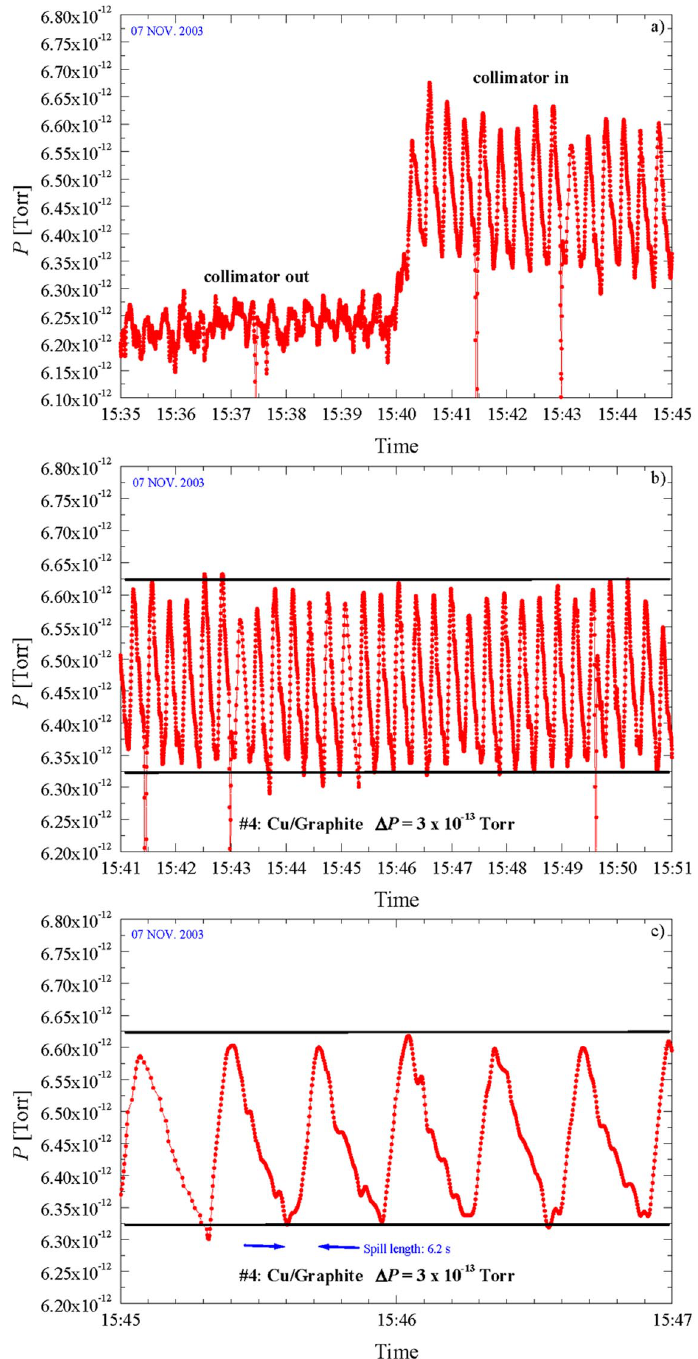
FIG. 4. (Color) Pressure rises of the Cu = graphite collimator bombarded under 35 mrad with 158 GeV = u In 49 (cid:1) ions at the SPS. The intensity was (cid:7) 1 : 5 (cid:2) 10 6 ions = spill with a spill length of 6.2 s. (a) Pressure rise when the sample was moved at 15:40 h into the ion beam, (b) pressure rise during continuous bombardment, and (c) magnification of to the temperature rise # T is then given by tions and the subsequent temperature calculations carbon was taken into account with a density of 1 : 84 g = cm 3 and a E dep : specific heat capacity of 795 J = (cid:9) kg K (cid:10) . Copper was simu- # T (cid:4) (cid:18) (cid:2) c lated with a density of 8 : 96 g = cm 3 and a heat capacity of 385 J = (cid:9) kg K (cid:10) . The ion beam parameters (energy, size, The bare graphite and the Cu = graphite collimators were chosen to study the heating effect. For the simula- impact angle) and the collimator dimensions were taken